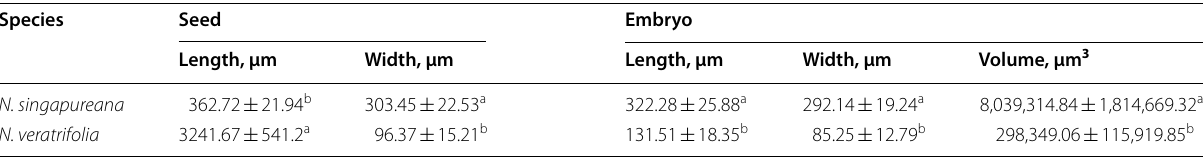
Data are mean SD. Means within a column followed by the same letter are not significantly different at P ±